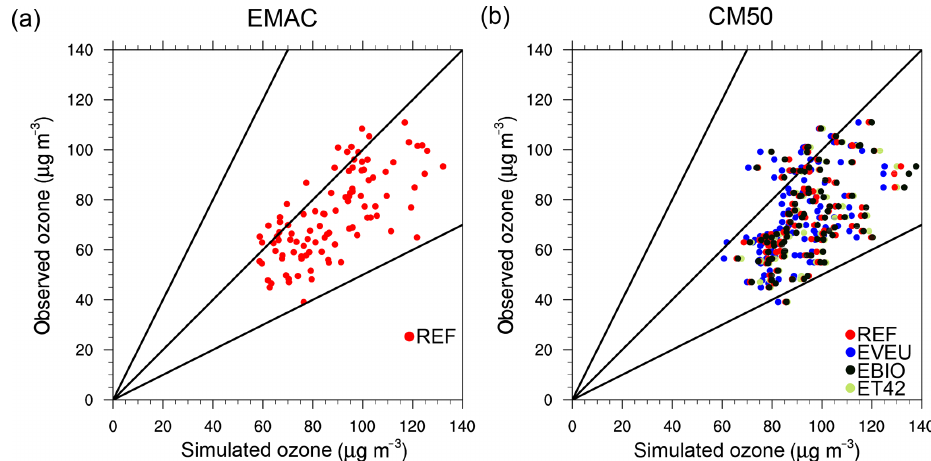
Figure 4. Scatter plot of the observed versus simulated ozone concentrations (in micrograms per cubic metre) in (a) EMAC and (b) CM50. Each dot represents a monthly mean value for one station in the period from June to August 2008. The black lines indicate the 1:1 line (observed and simulated concentrations are equal) and the range (between lines with slopes of 0.5 and 2, indicating a factor of 2). For EMAC, only the results of the REF simulation are shown, as the set-up of EMAC is identical in all